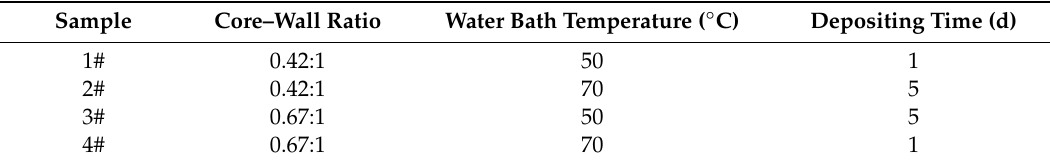
Table 1. Orthogonal experimental arrangements.